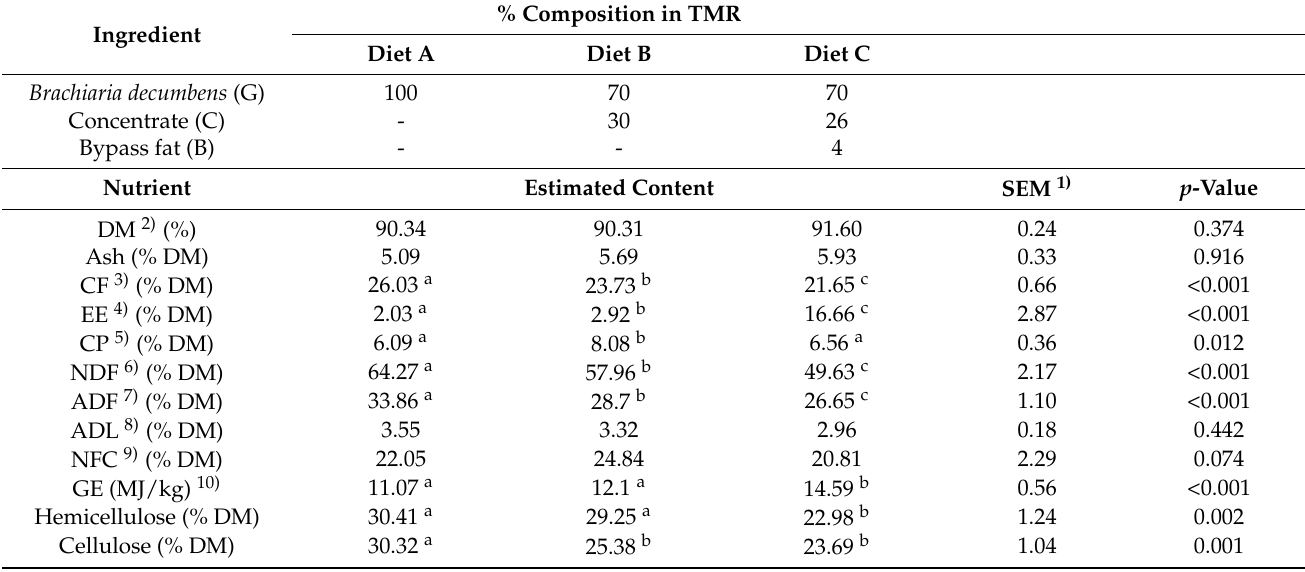
Table 2. Nutritional composition of experimental diets, based on a dry matter